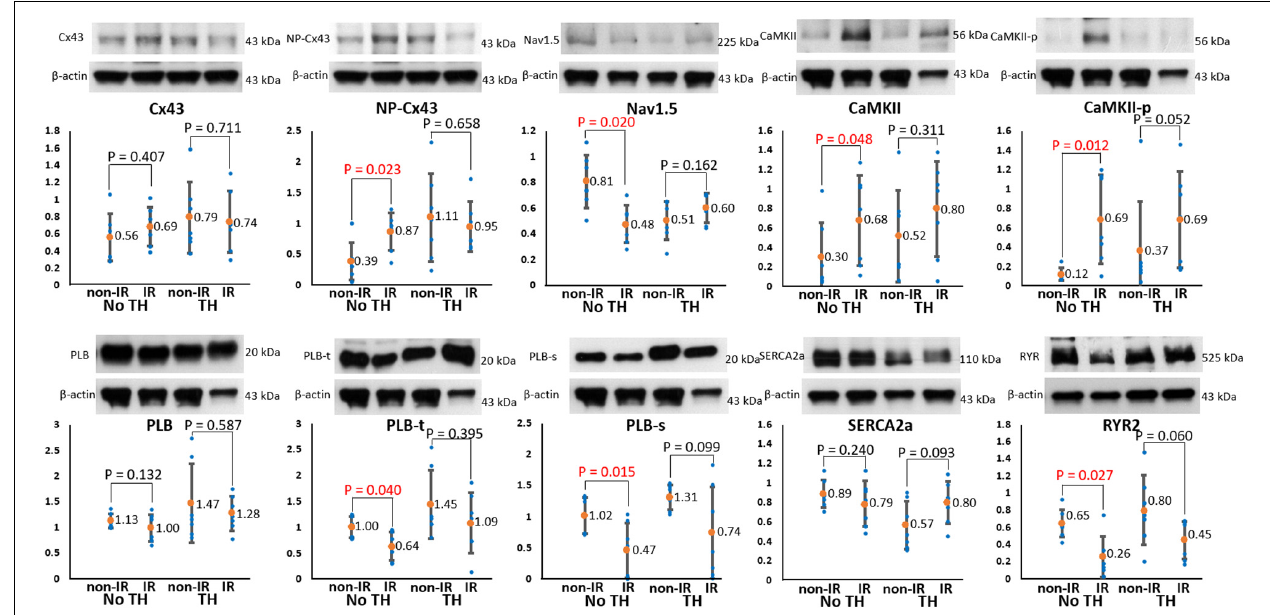
FIGURE 8 | Results of protein analyses. Representative examples of channel proteins (upper subpanels) and summarized results of channel proteins (lower subpanels) ( n = 6, Student’s t -test for all comparisons). Non-phosphorylated connexin43 (NP-Cx43), calmodulin-dependent protein kinase II (CaMKII), and pThr287-CaMKII (CaMKII-p) expression was significantly upregulated, and Nav1.5, pThr 17 -phospholamban (PLB-t), pSer 16 -phospholamban (PLB-s), and ryanodine receptor (RYR2) expression was significantly downregulated in the ischemia–reperfusion (IR) zone in the non-therapeutic hypothermia (TH) group but not in the TH group. Because of technical issues and various protein sizes, Western blots protein analyses were conducted at different gels. The illustrative examples of Cx43 and NP-Cx43 were acquired from no-TH heart 1 and TH heart 1; the examples of CaMKII, CaMKII-P, PLB, PLB-t, PLB-s were from no-TH heart 2 and TH heart 2; the examples of Nav1.5 were from no-TH heart 3 and TH heart 3; the examples of sarcoplasmic reticulum Ca-ATPase (SERCA2a) were from no-TH heart 4 and TH heart 4; the examples of ryanodine receptor (RYR2) were from no-TH heart 5 and TH heart